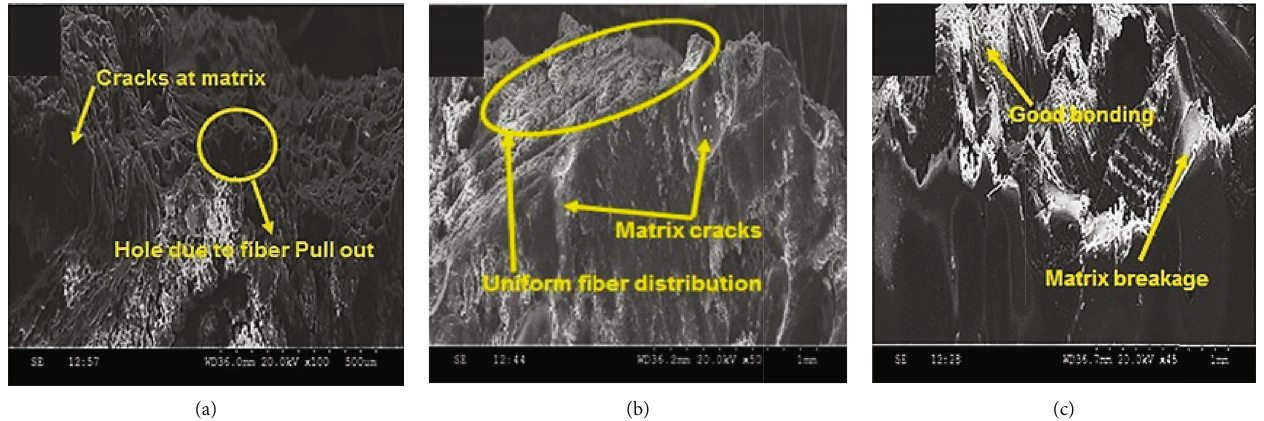
Figure 12: Microstructural image of fractured specimen after (a) tensile; (b) fl exural; (c) impact testing.